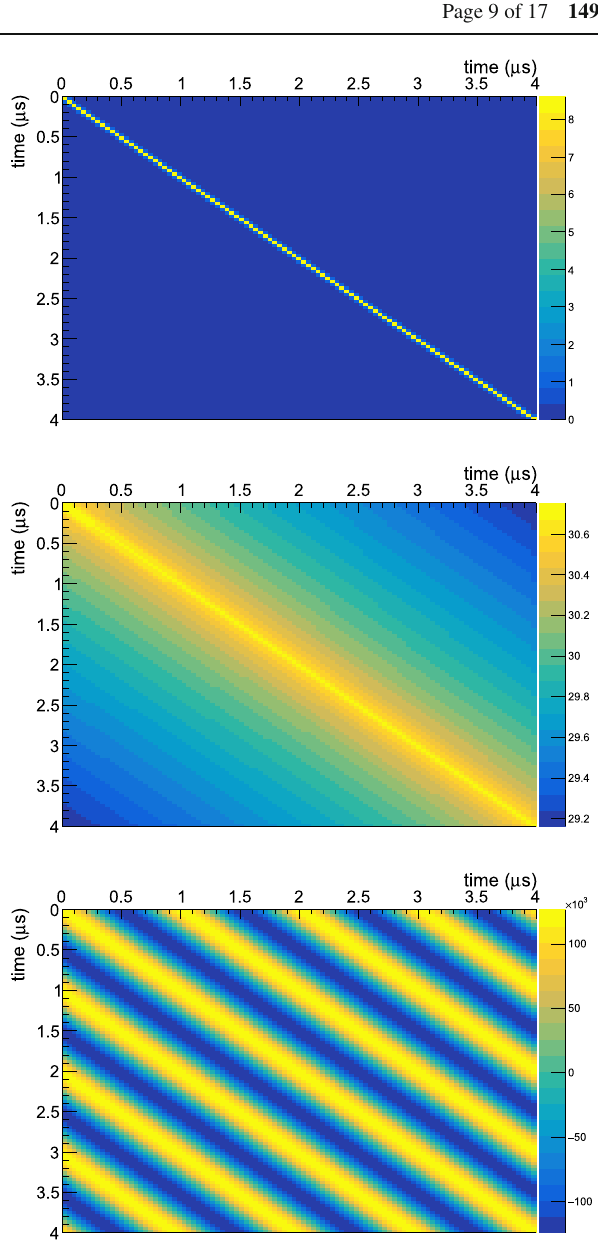
Fig. 7 Noise matrix layouts in three configurations: (i) series noise (top panel); (ii) series and parallel noise (middle panel) and (iii) series noise and sinusoidal disturbances (bottom panel)